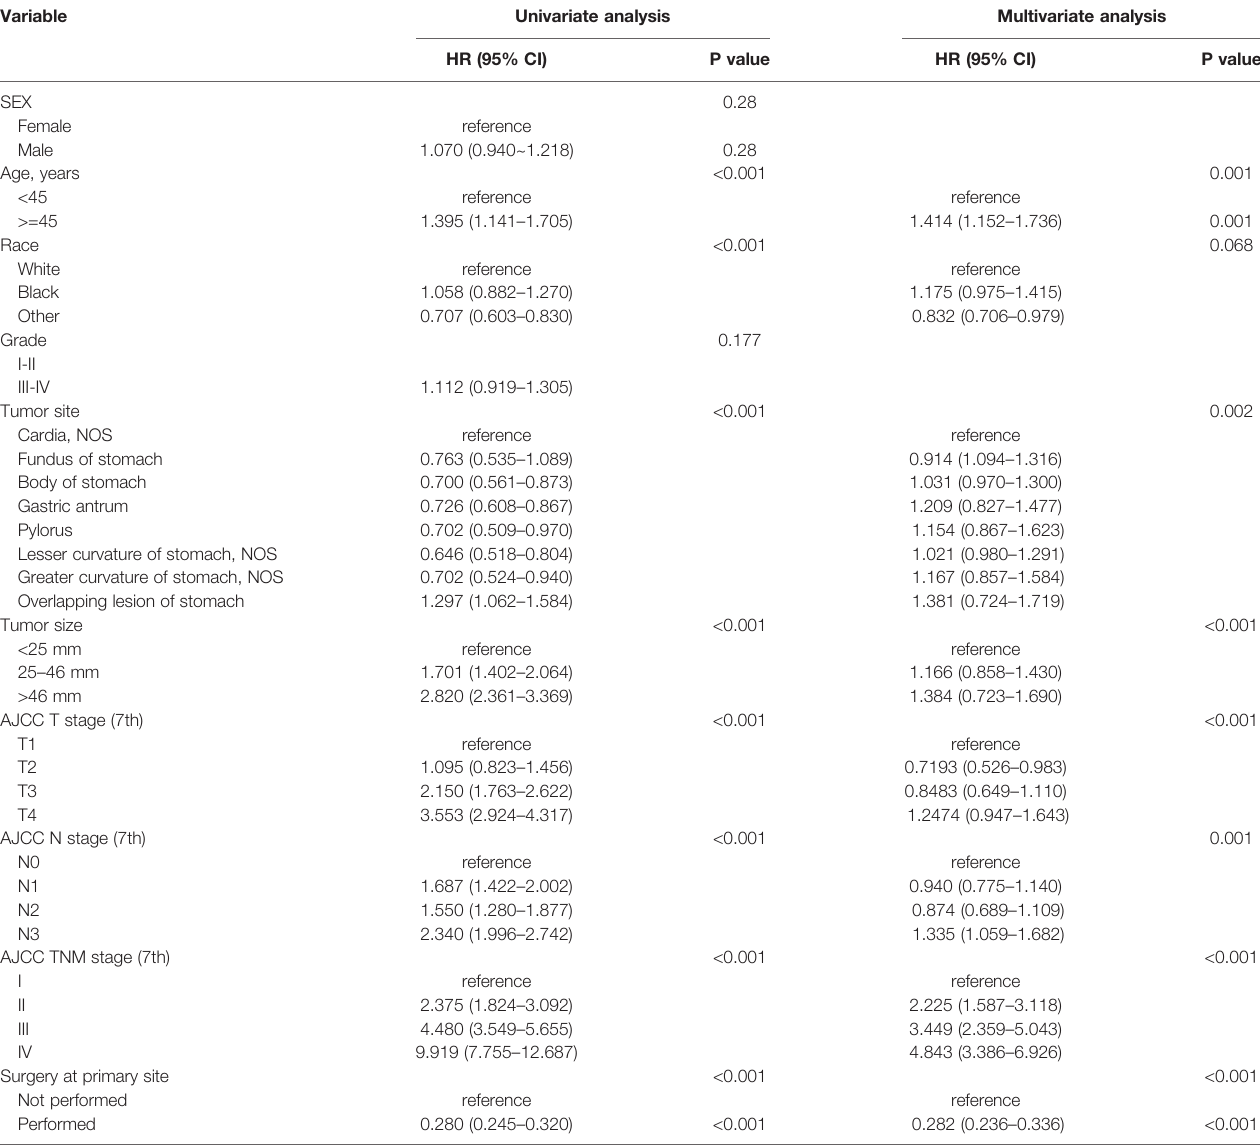
TABLE 4 | Univariate and multivariate analyses of prognostic factors associated with overall survival of patients with SRC.